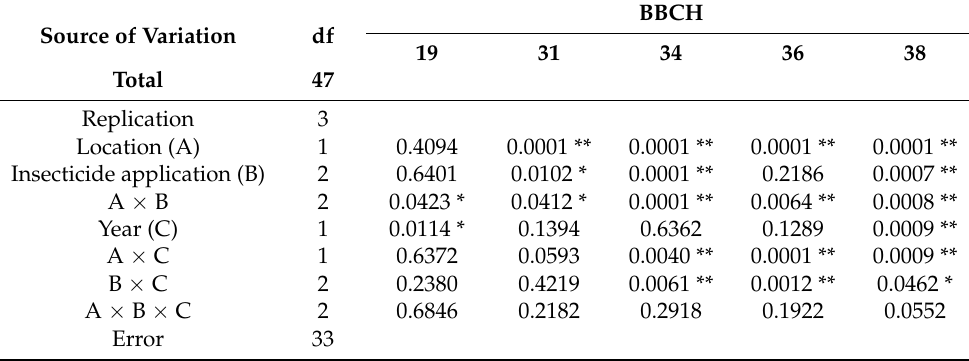
Table 10. Factorial analysis (ANOVA) of the percent of damages caused by aphids in different developmental stages of sugar beet plants (* significant at p = 0.05, ** significant at p = 0.01.). BBCH Source of Variation df 19